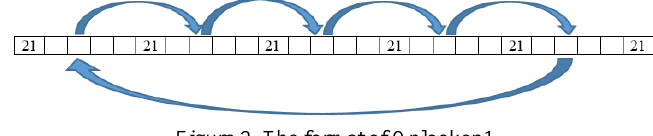
Figure 2. The format of Onlooker 1